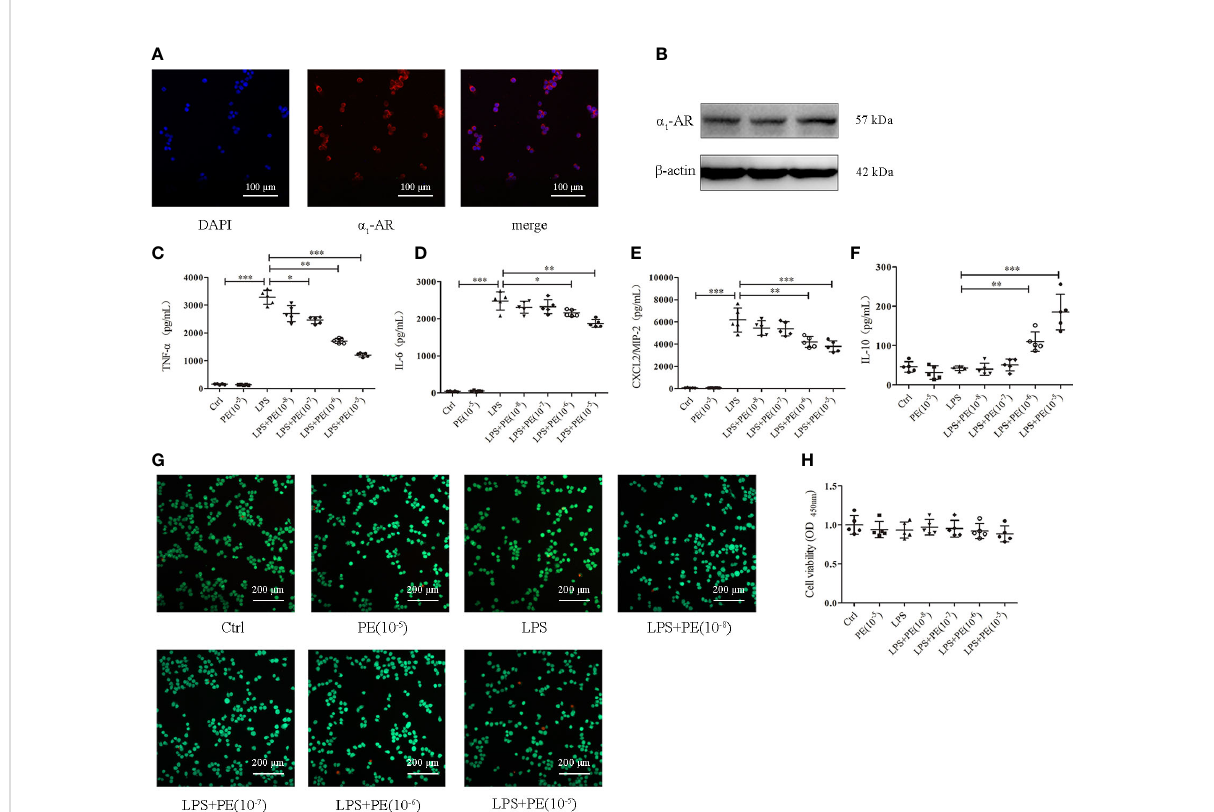
FIGURE 3 Phenylephrine (PE) inhibited in fl ammation in lipopolysaccharide (LPS)-activated murine alveolar macrophages without in fl uencing cell viability. MH-S cells were incubated with PE (10 -8 -10 -5 M) for 30 min, followed by LPS (100 ng/mL) for 6 h Expression of a 1 -AR in MH-S cells was detected by immuno fl uorescence (A) and western blotting (B) . Levels of TNF- a (C) , IL-6 (D) , CXCL2/MIP-2 (E) , and IL-10 (F) released from MH-S cells. (G) Live and dead cells were stained by calcein-AM and propidium iodide, respectively. Scale bar = 200 m M. (H) Cell viability was measured by CCK-8 assay. Data are represented as the mean ± SD, n = 5 per group. * p < 0.05, ** p < 0.01, *** p <